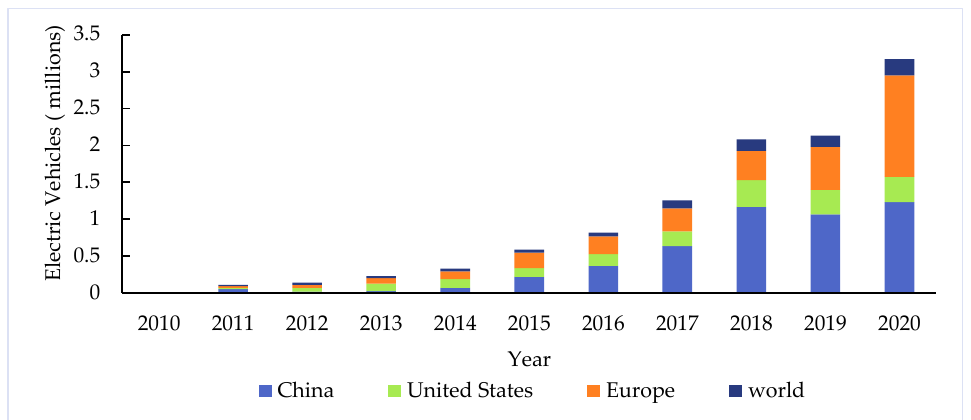
Figure 1. Worldwide sales of EVs in millions of units .